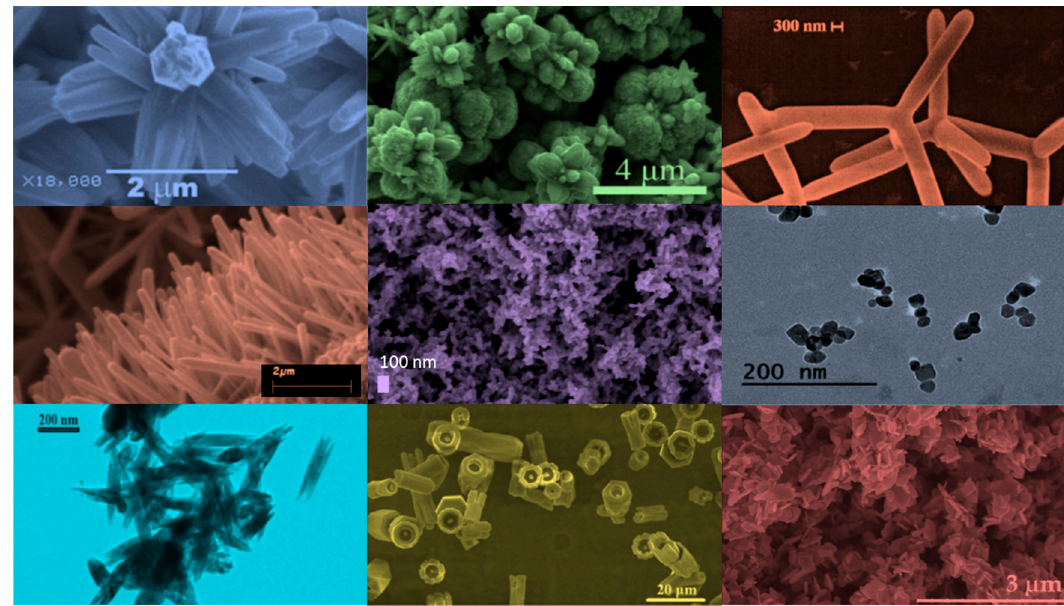
Figure 3. Possible morphologies of ZnO nanostructured systems. From left to right and from top to bottom: nanoflowers (adapted from ref. [149]), nanopods (adapted from ref. [147]), nanorods (adapted from ref. [148]), mesoporous films, spherical nanoparticles, nanoneedles (adapted from ref. [150]), hollow microcolumns (adapted from ref. [151]), and micropods (adapted from ref. [152]).